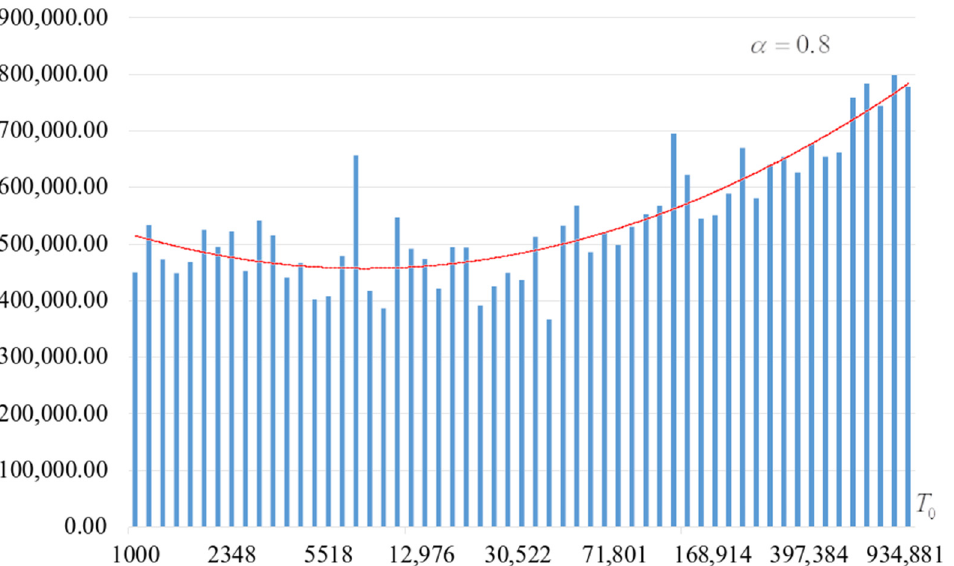
Figure 20. The summary number of the arithmetic mean number of iterations when searching for the target S-box, 𝛼 = 0.8 .